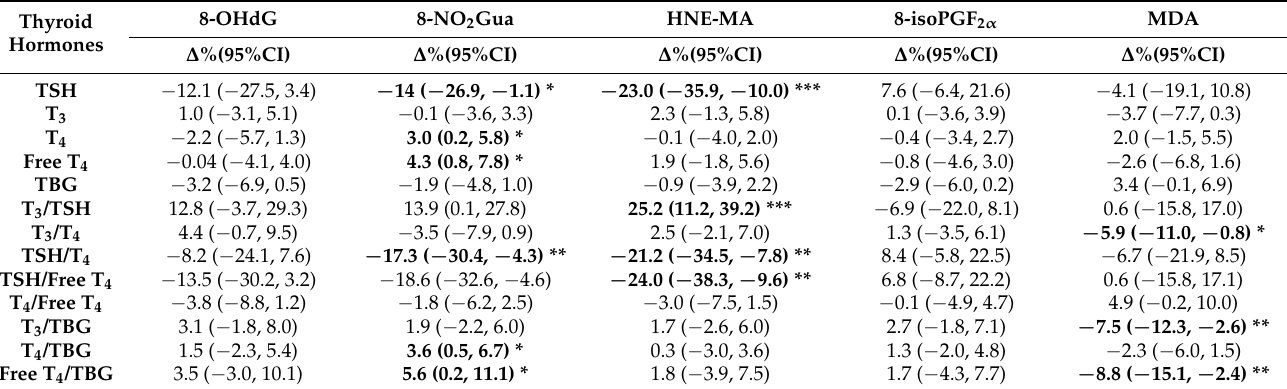
Table 4. Percent changes a in concentrations of thyroid hormones in association with tertile increase in oxidative/nitrosative stress biomarker concentrations across three visits (N = 218).